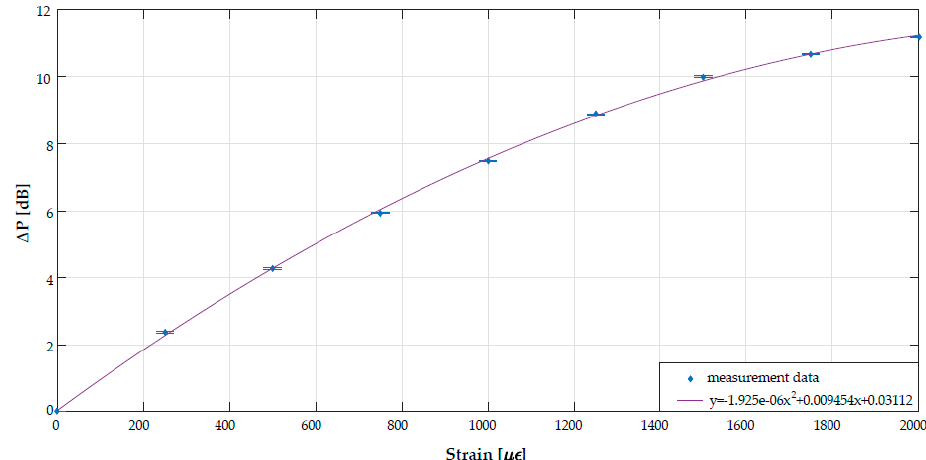
Figure 5. The output light spectra for different stretched PM-PCF.